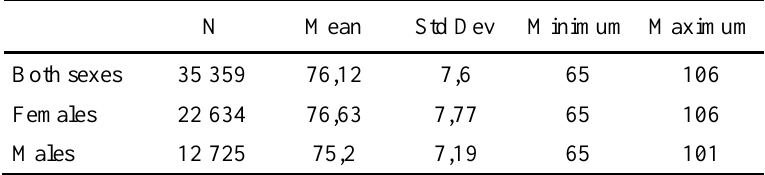
Age distribution of the sample N Mean Std Dev Minimum Maximum Both